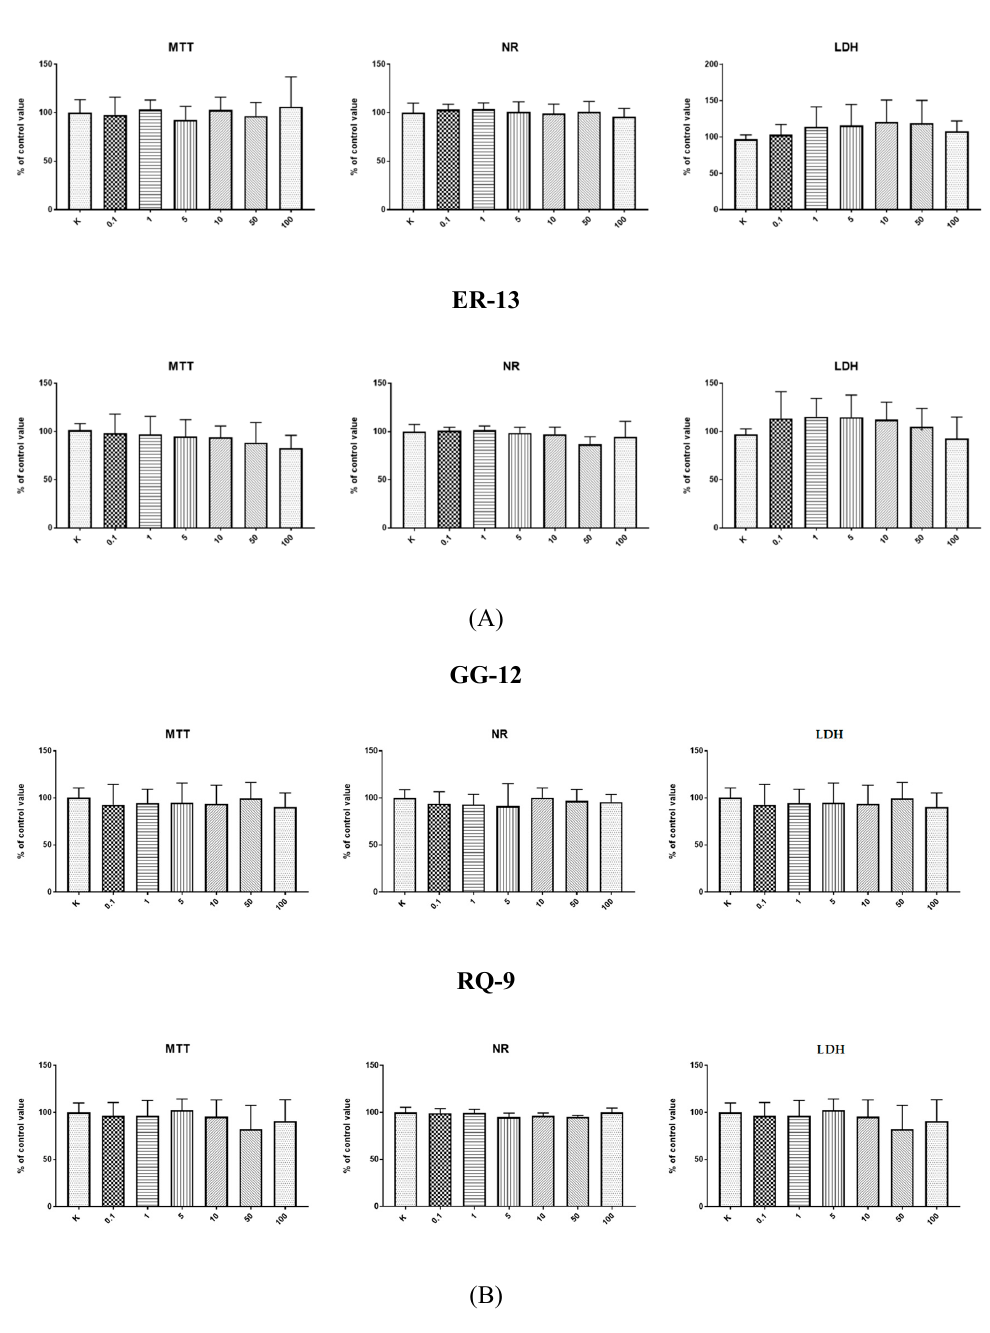
Figure 1. ( A ) Result of MTT, neutral red (NR), and LDH tests for peptides, * p < 0.05; ** p < 0.01; *** p < 0.001; **** p < 0.0001; ( B ) Result of MTT, neutral red (NR), and LDH tests for peptides.